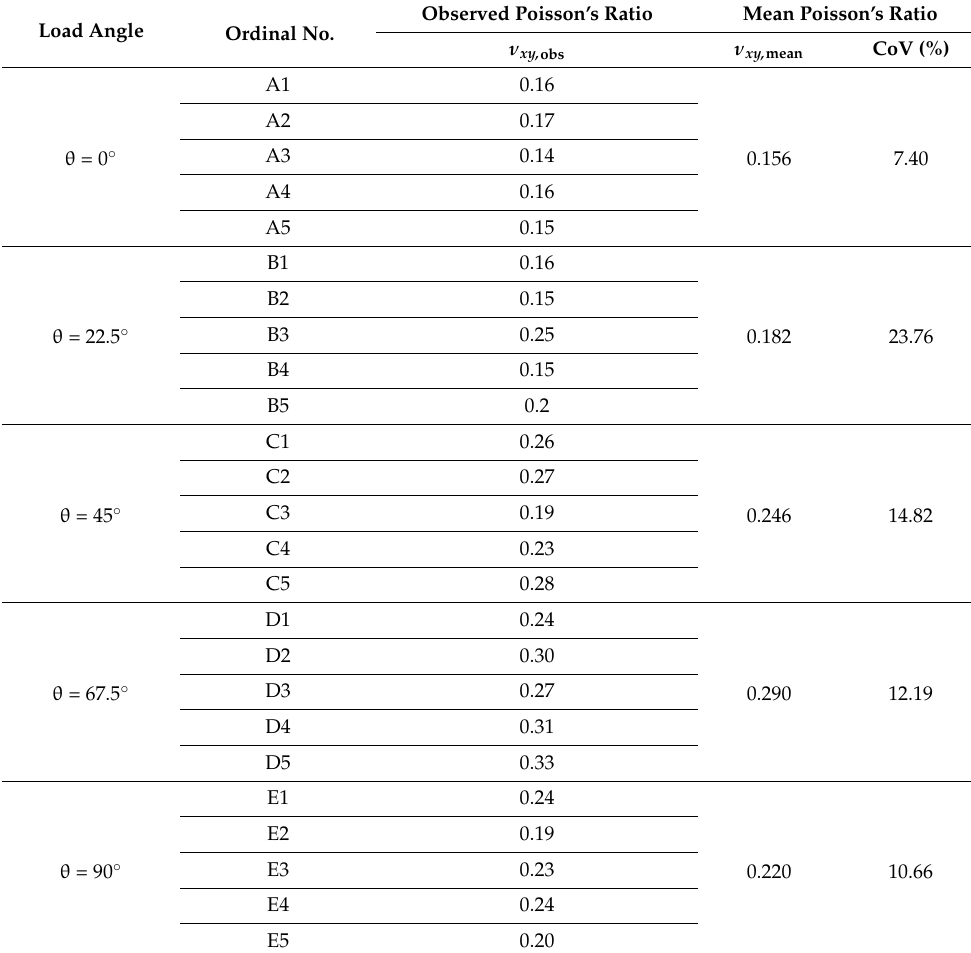
Table 4. Poisson’s ratio testing results of wall samples with different angles of bed joints θ . Observed Poisson’s Load Angle Ordinal No.